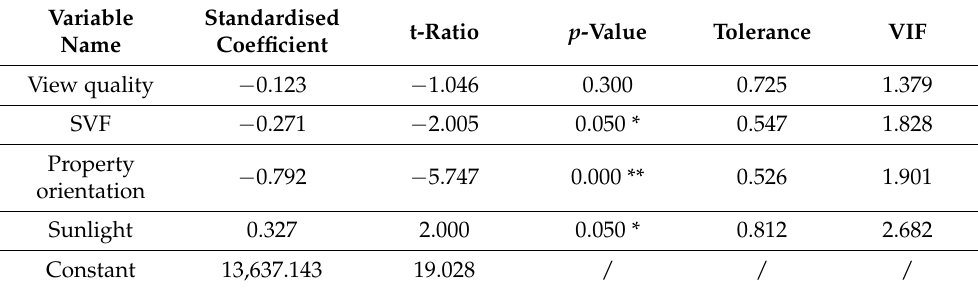
Table 7. Descriptive statistics of the 3D model.